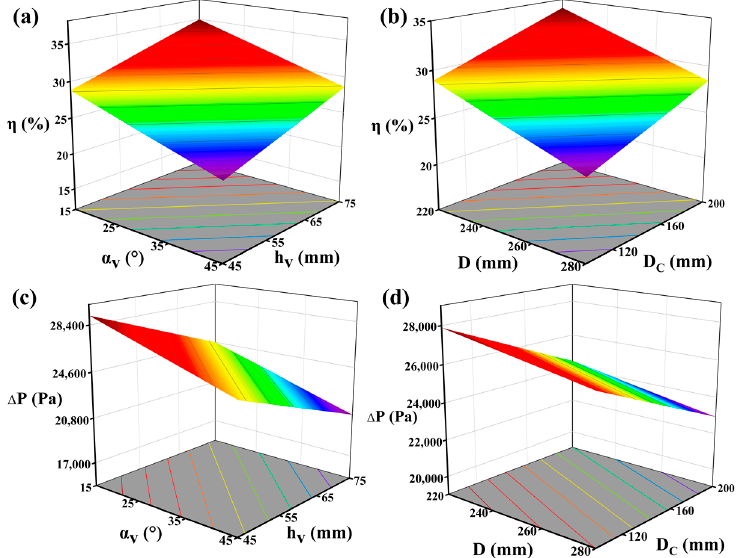
Figure 8. The influence of guide vane and cone diameter on response parameters.